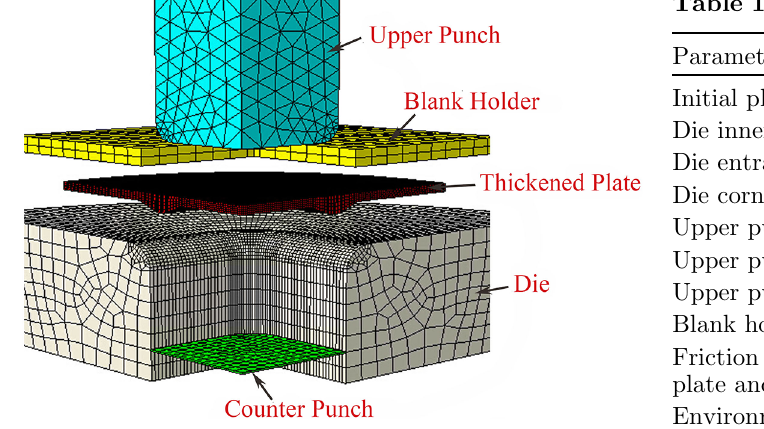
Fig. 2. The three-dimensional FE model of hot stamping of square cups.